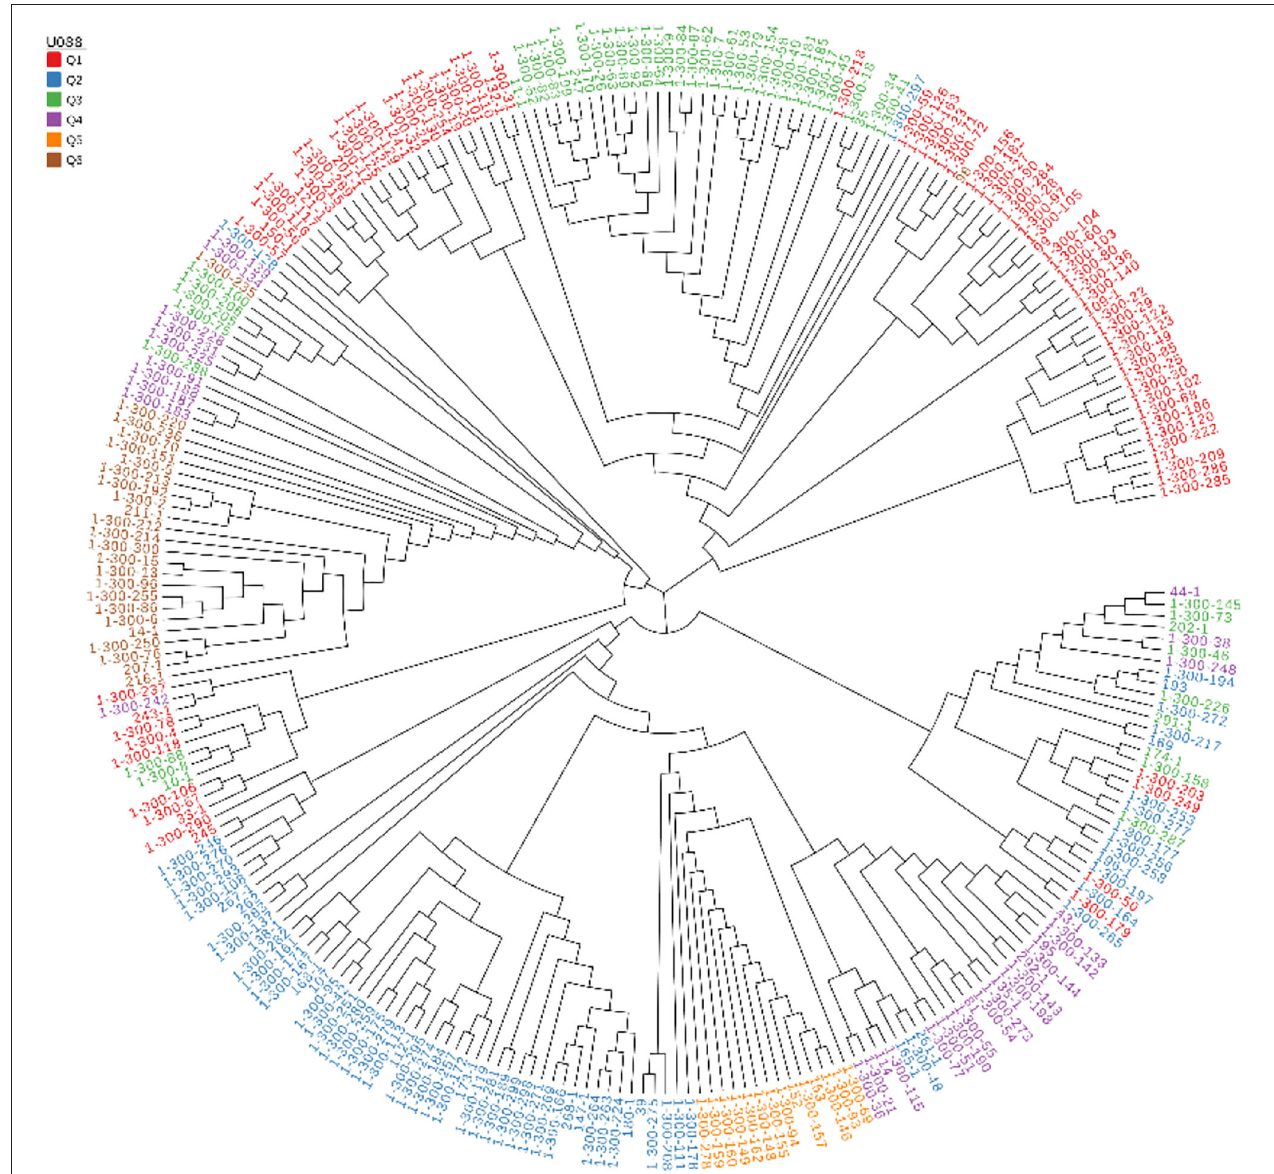
FIGURE 2 | Genetic relatedness among the 269 hulless barley lines estimated by neighbor-joining method and represented as a polar tree diagram. The estimated genetic relatedness is based on 5,949,446 SNPs identified by genotyping-by-sequencing and filtered for MAF of 0.05.